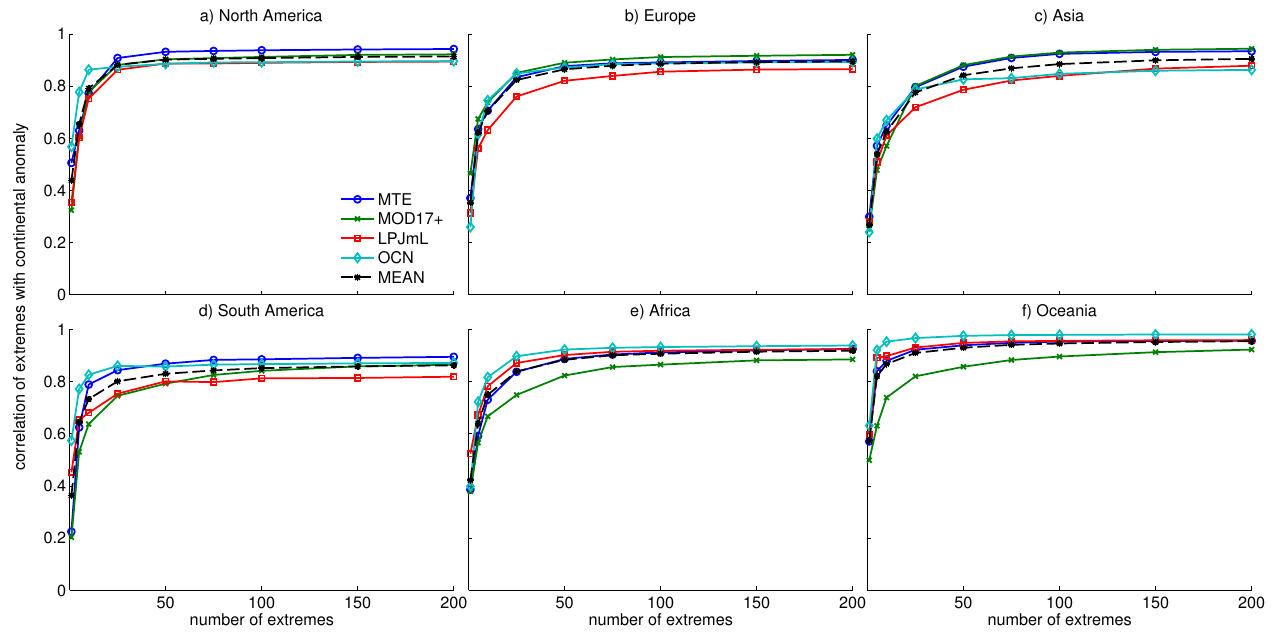
Figure 3. Correlations of 10th-percentile extremes (positive and negative) with the continental GPP anomalies. Depicted are the correlation coefficients for the data sets MTE (blue circles), MOD17+ (green cross), LPJmL (red square), OCN (cyan diamond). The dashed black line shows the mean of the correlation coefficients of the four data